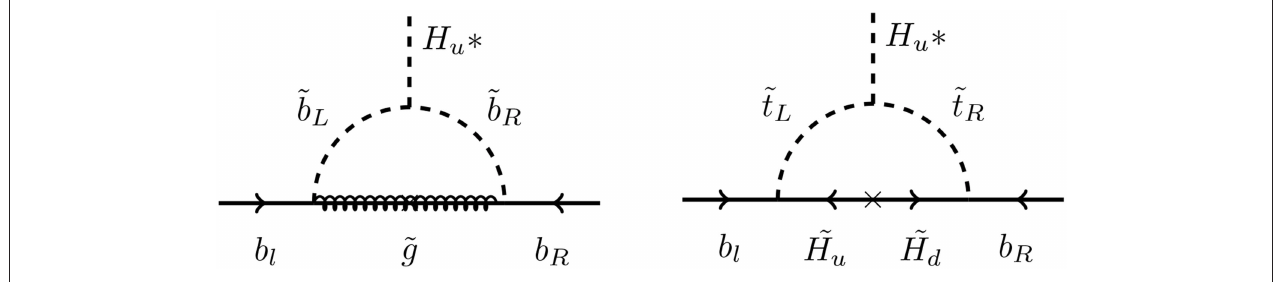
FIGURE 6 | One-loop radiative corrections to m b